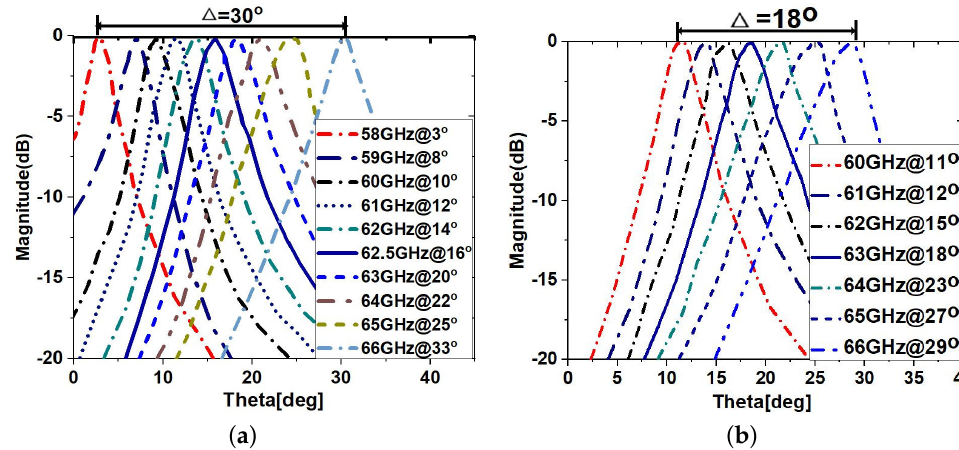
Figure 6. Theoretically estimated beam scanning range of the LWA from 58 to 66 GHz for a fixed cavity height of ( a ) h a 1 = 2.90 mm with HIS and ( b ) h a 1 = 3.32 mm without HIS.